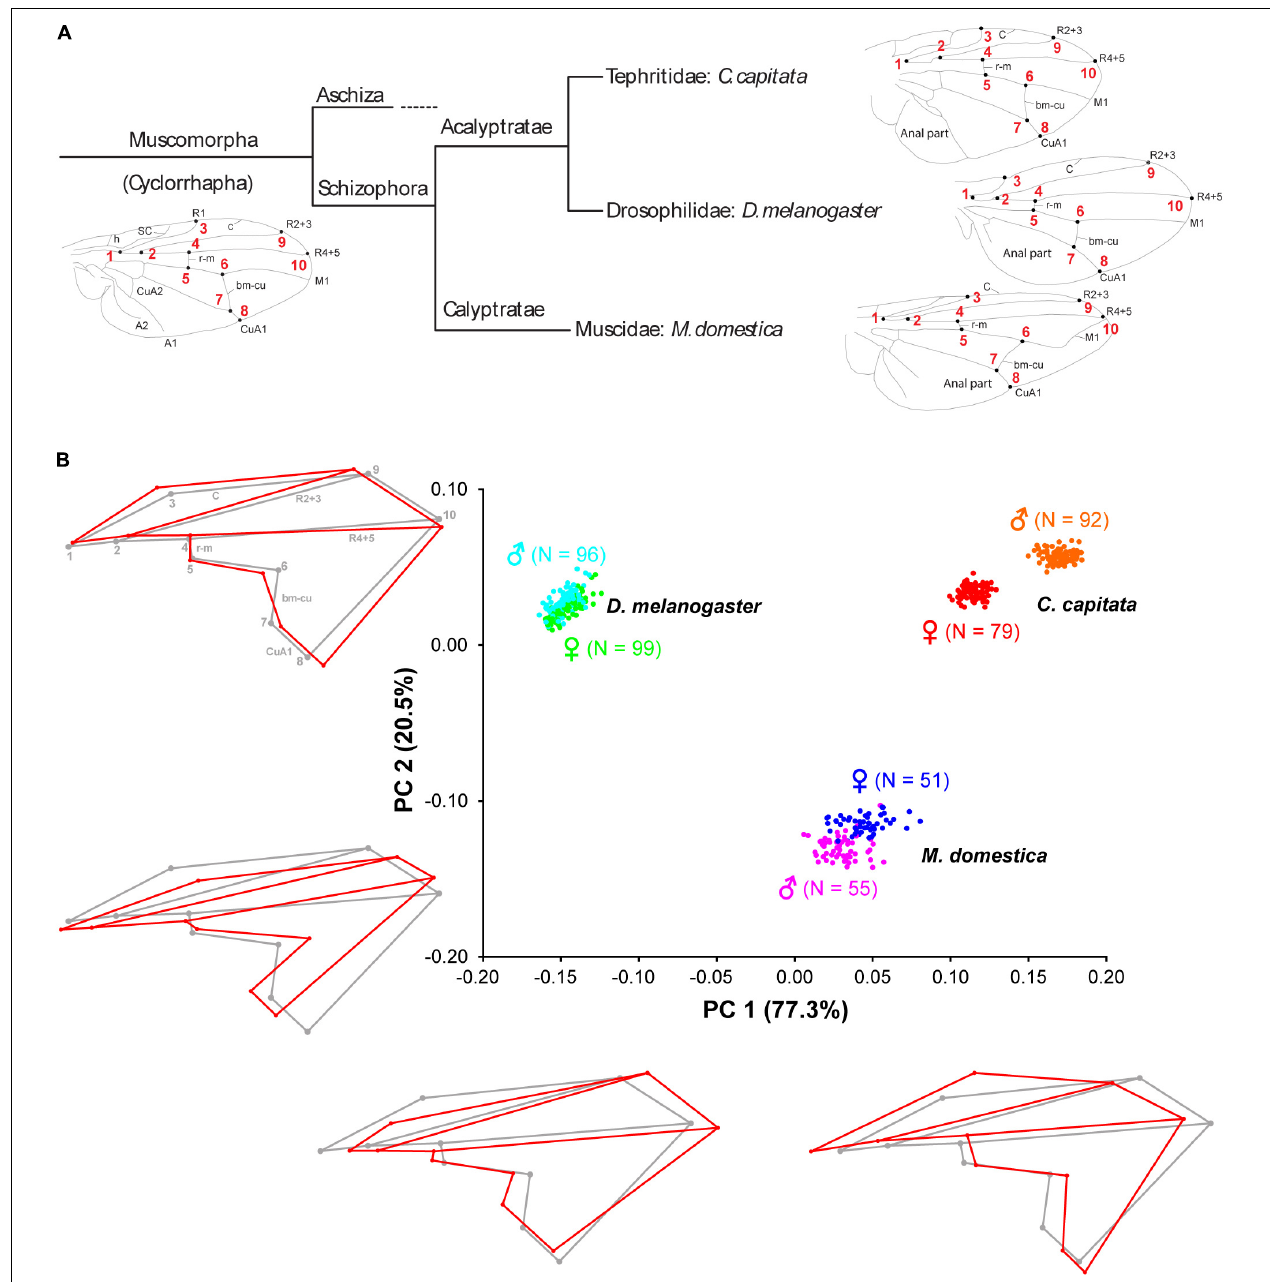
FIGURE 1 | Schematic overview of the phylogenetic relationships Muscomorpha and interspecific wing shape variation D. melanogaster, C. capitata , and M. domestica . (A) Homologous landmarks 1–10 in C. capitata , D. melanogaster , and M. domestica are shown as black points with the respective number in red. A, anal vein; bm-cu, basal-madial-cubital crossvein; CuA, anterior cubital vein; C, costal vein; h, humeral crossvein; M, medial vein; R, radial veins; r-m, radio-medial crossvein; SC, subcosta. Branch lengths of the tree do not indicate evolutionary time or distance. (B) Wing shape variation between D. melanogaster , C. capitata, and M. domestica . Principal Component Analysis of shape (PC1 and PC2). The red wireframes depict shape changes along the main axes of variation (PC1: –0.2, 0.2; PC2: –0.2, 0.1) relative to the gray wireframes (0 for both axes). The amount of variation explained by each PC is shown in brackets and the number of individuals analyzed for each sex is provided next to each